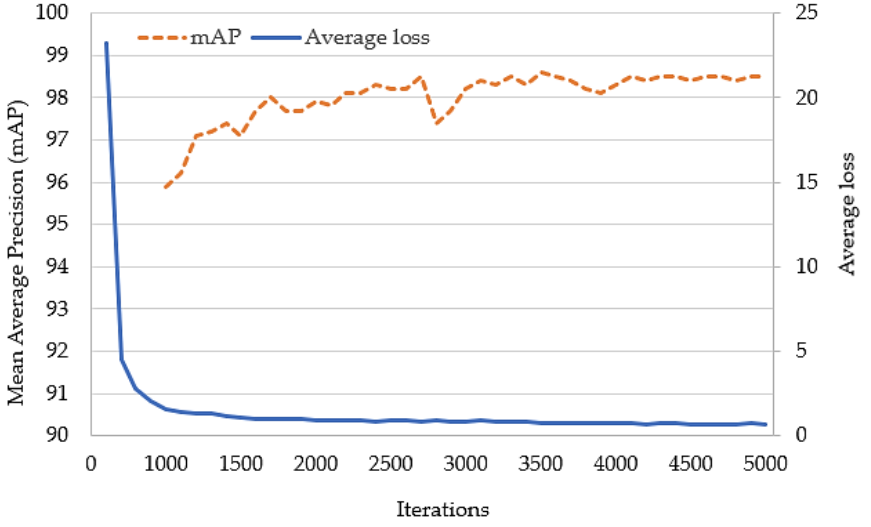
Figure 10. Precision-Loss chart for the training of YOLOv4-tiny model. Table 4. Performance comparison of YOLO models for a mango fruit detection application. Training and test sets of [13] were used. Best result for a given criterion is shown in bold.